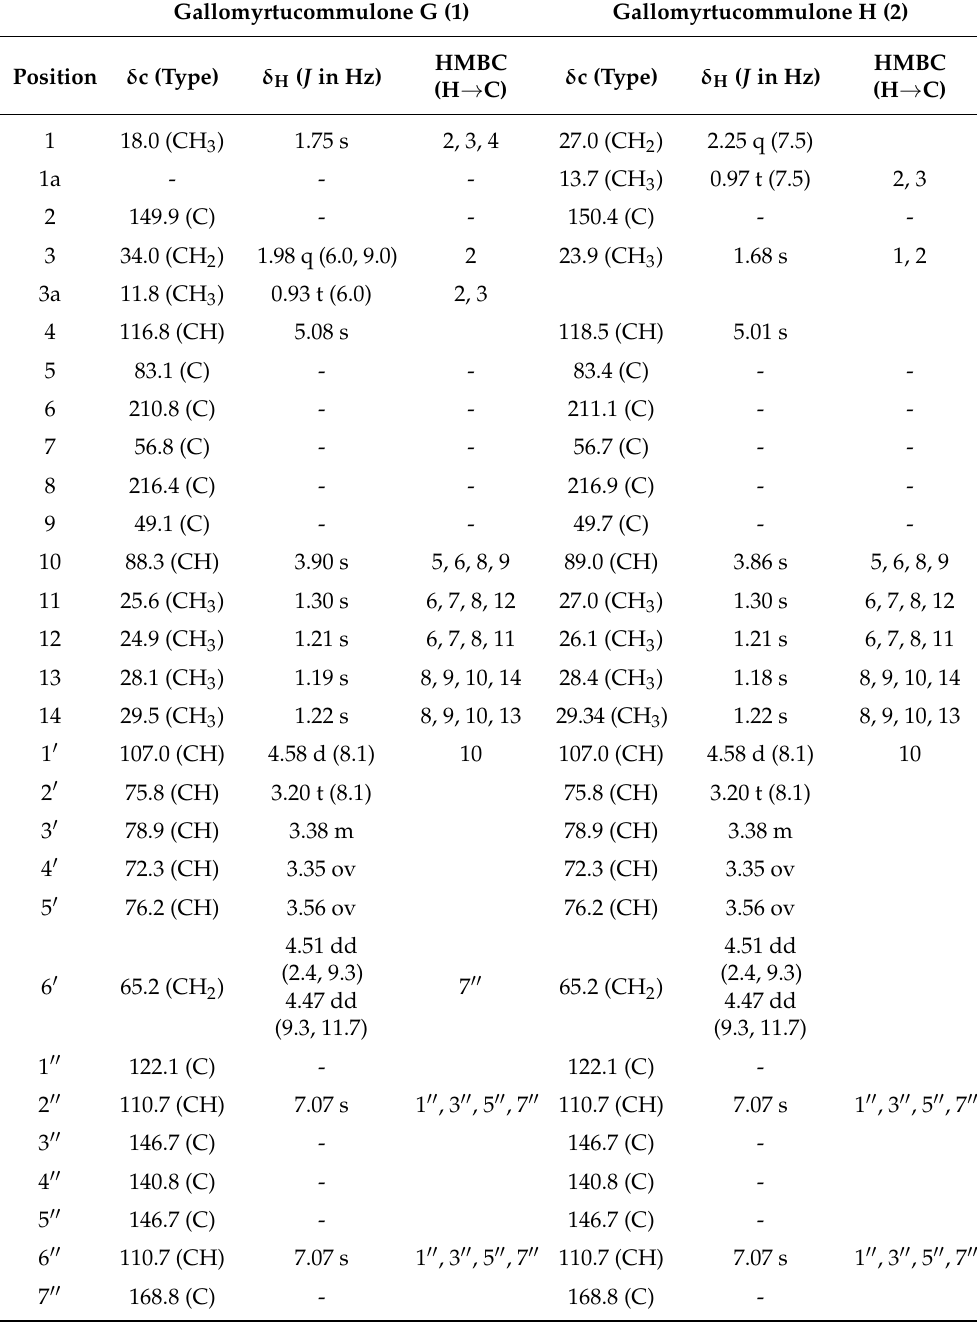
Table 1. NMR data of compounds 1 – 2 in CD 3 OD 1